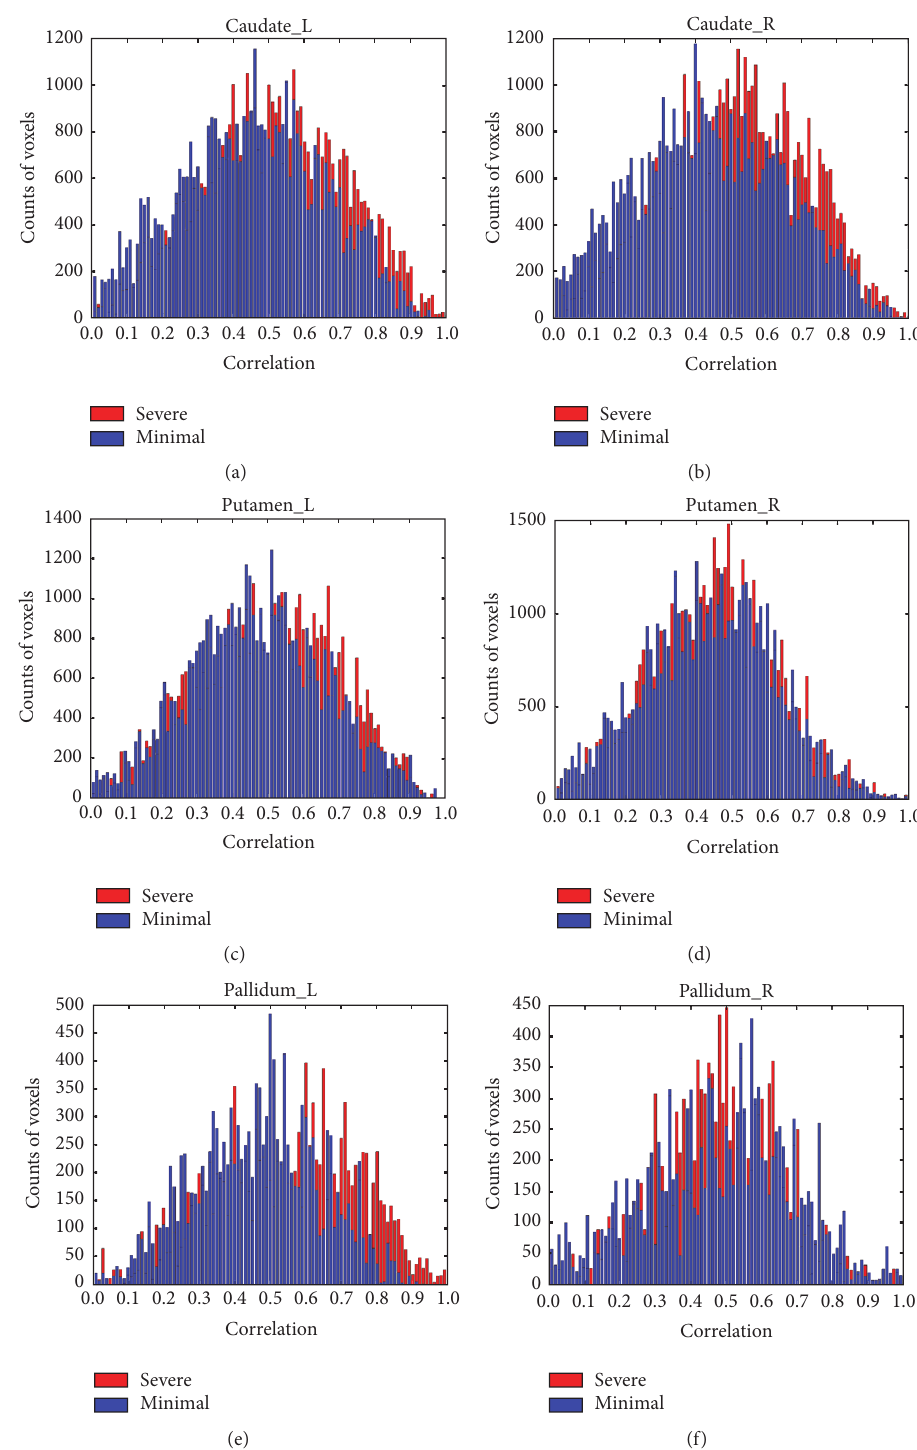
Figure 1: Comparisons of histogram plots of correlation coefficients over all subjects in the bilateral basal ganglia (caudate, putamen, and pallidum). Blue bins = data for minimal fatigue stage. Red bins = data for significant fatigue stage. Voxels with very low correlation (𝑟 < 0.001) were excluded for better visualization of coefficient distribution of the voxels in each ROI. In the significant fatigue stage, a larger number of voxels (red bins) can be seen with higher correlation (FC with seed area in M1) values in mid-to-high correlation range in all basal ganglia